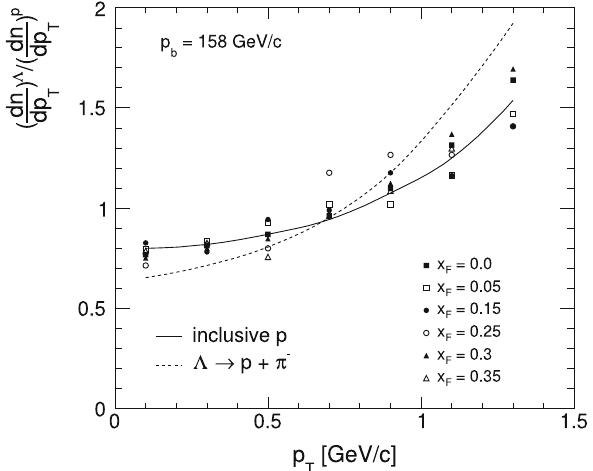
Fig. 13 Ratio ( dn / dp T ) Λ /( dn / dp T ) p as a function of p T at p beam =158 GeV/c. The dots at different p T values represent the mea- surements for 6 values of x F between x F = 0 and x F = 0.35. For com-